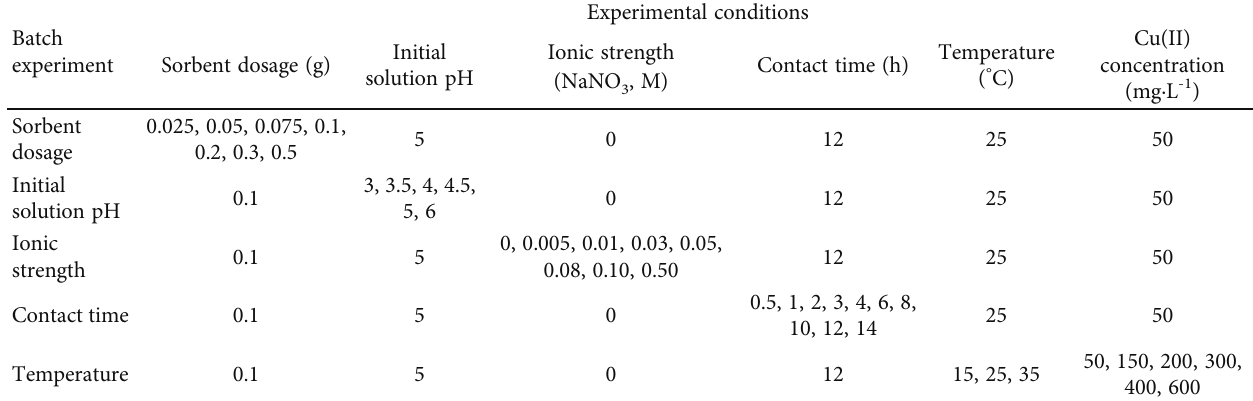
Figure 1: Flow chart of SP-SBC preparation. Table 1: Speci fi c conditions for each batch